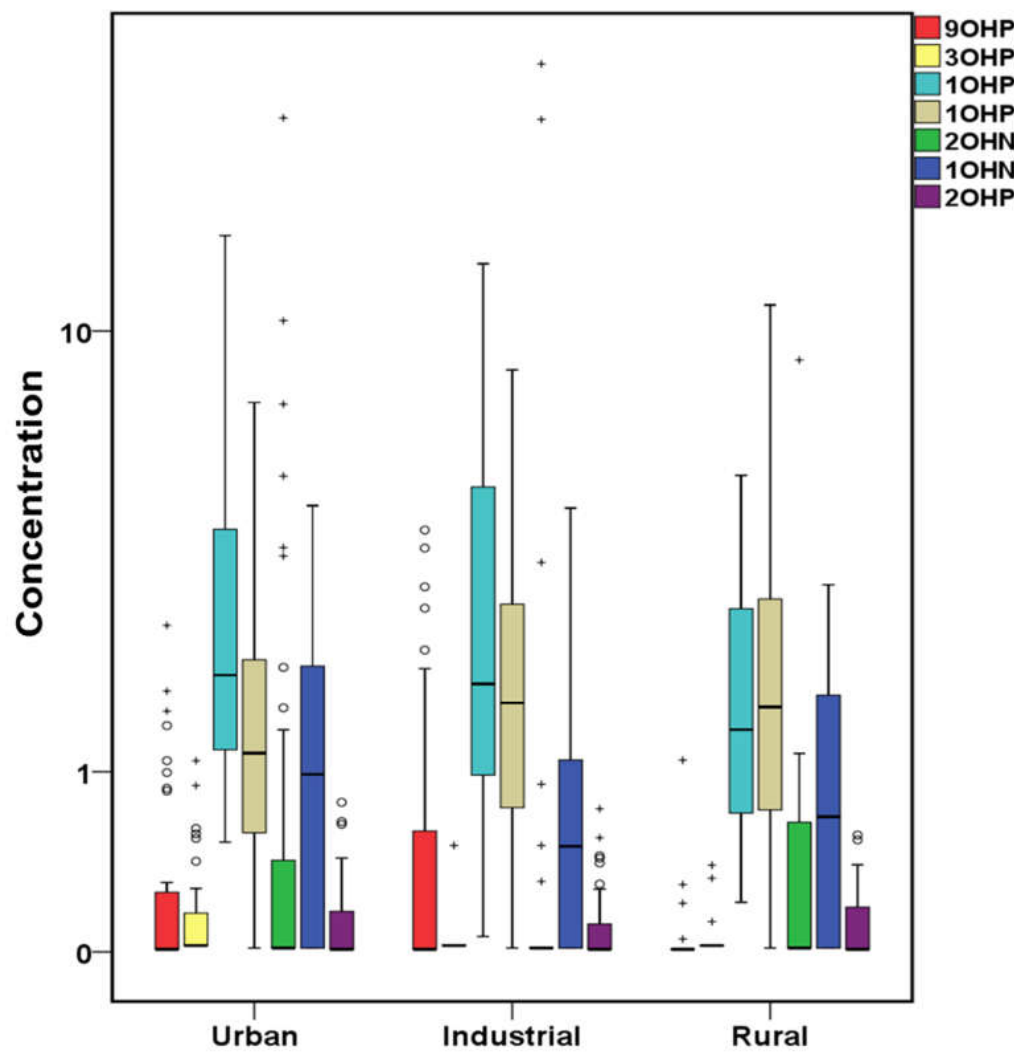
Figure 10. OHPAHs variation according to the area of residence of cases in μg L −1 ( + outliers and o values above 3rd quartile and * p -value <0.05) in logarithmic scale (9OHPHE:9-hydroxyphenanthrene, 3OHPHE:3-hydroxyphenanthrene, 1OHPYR:1-hydroxypyrene, 1OHPHE:1-hydroxyphenanthrene, 2OHNAP:2-naphthol, 1OHNAP:1-naphthol, 2OHPHE:2- hydroxyphenanthrene).